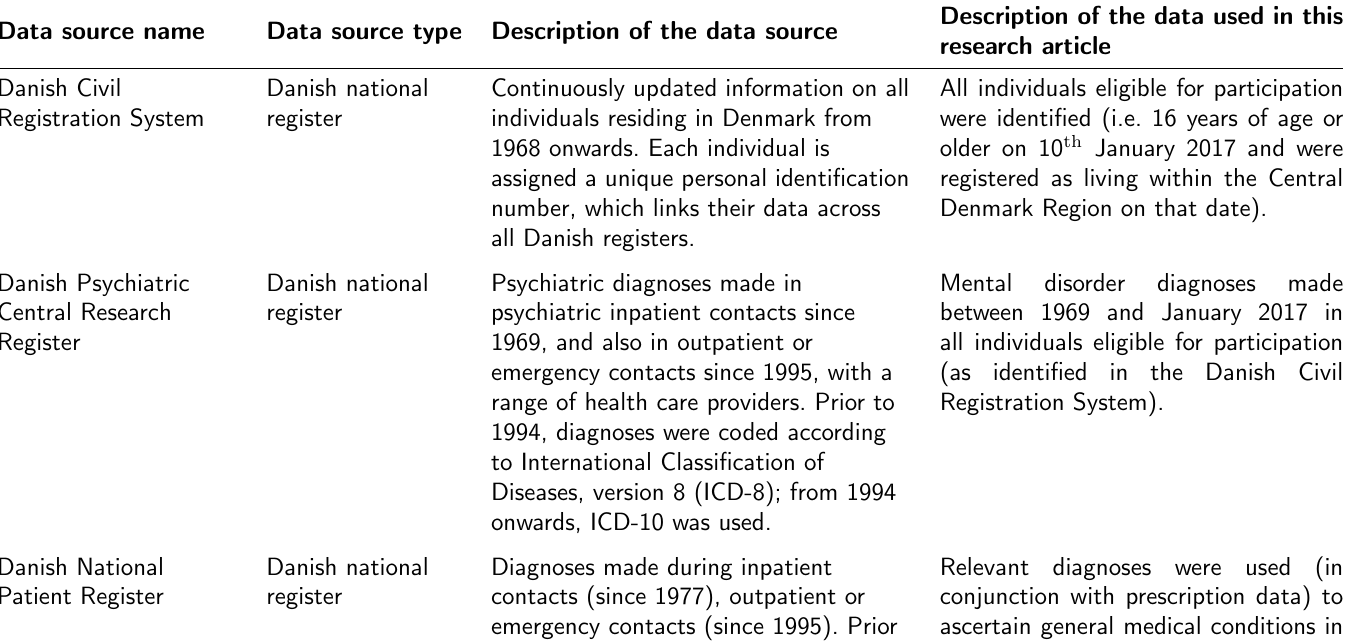
Supplementary Table 1: Summary of the data sources